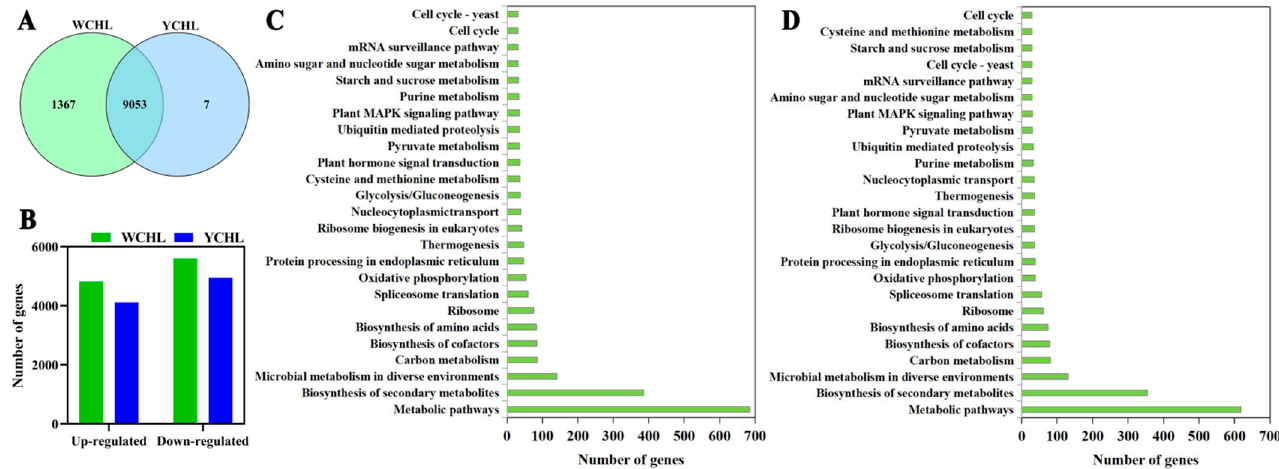
Figure 5. DEGs analyses of ‘WCHL’ and ‘YCHL’ pitaya pulps during three developmental stages. ( A ), Comparison of DEGs between ‘WCHL’ and ‘YCHL’ pitaya pulps; ( B ), the number of up- and down-regulated genes in ‘WCHL’ and ‘YCHL’ pitaya pulps; ( C , D ), the KEGG enrichment analysis of DEGs from ‘WCHL’ ( C ) and ‘YCHL’ ( D ) pitaya pulps.